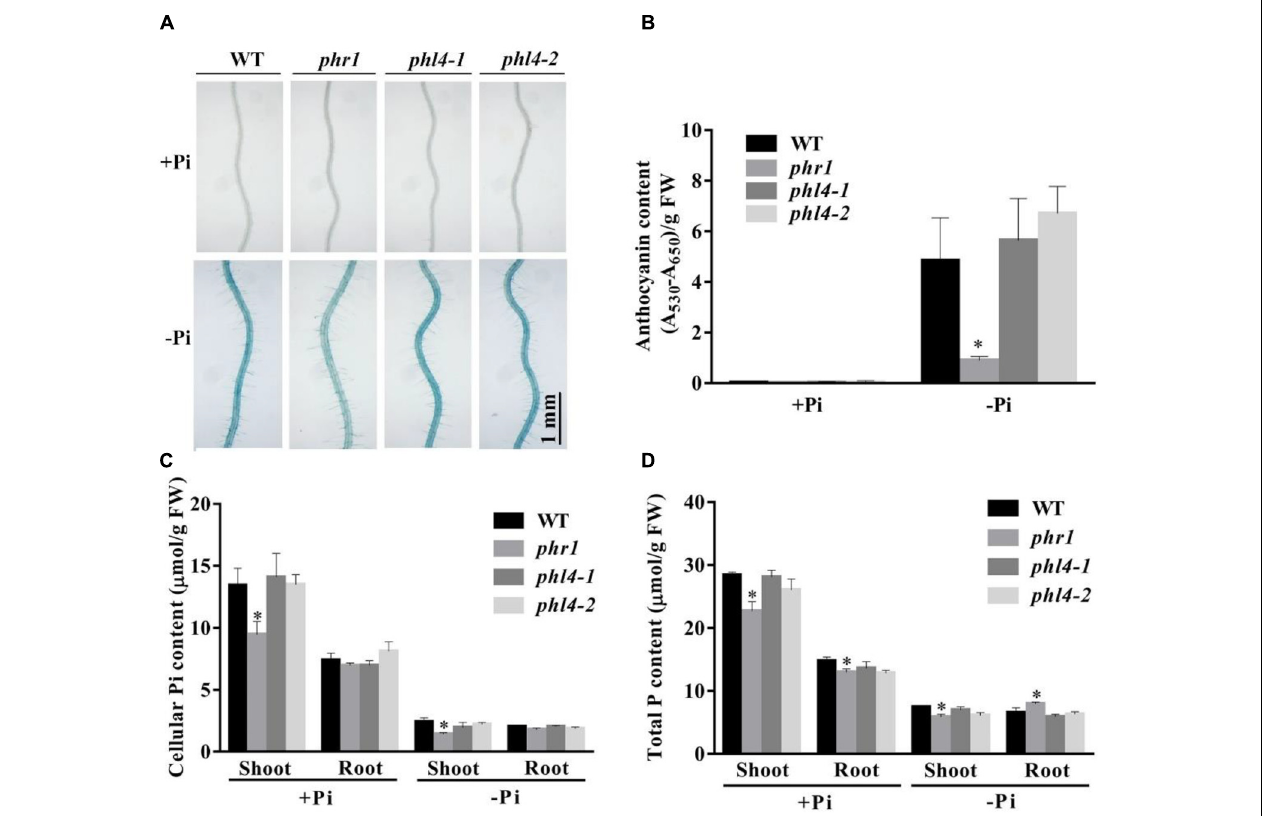
FIGURE 4 | Analyses of root-associated APase activity and contents of anthocyanin, cellular Pi, and total P in the WT, phr1 , phl4-1 , and phl4-2 on +Pi and –Pi media. (A) The APase activities revealed by BCIP staining of the root surfaces of 6-day-old seedlings of the WT and various mutants. (B) Anthocyanins in the shoots of 12-day-old seedlings of the WT and various mutants. (C,D) Cellular Pi and total P contents in the shoots and roots of 12-day-old seedlings of the WT and various mutants. These experiments were repeated three times with similar results. Values represent means ± SD of three replicates. Means with asterisks are significantly different from the WT ( P < 0.05, t